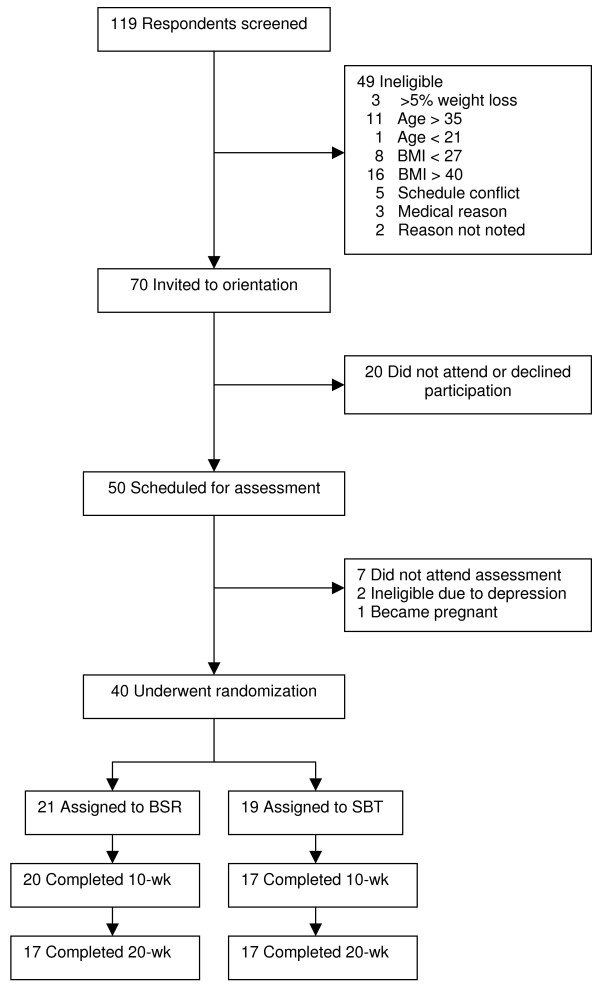
Study Enrollment and Retention.